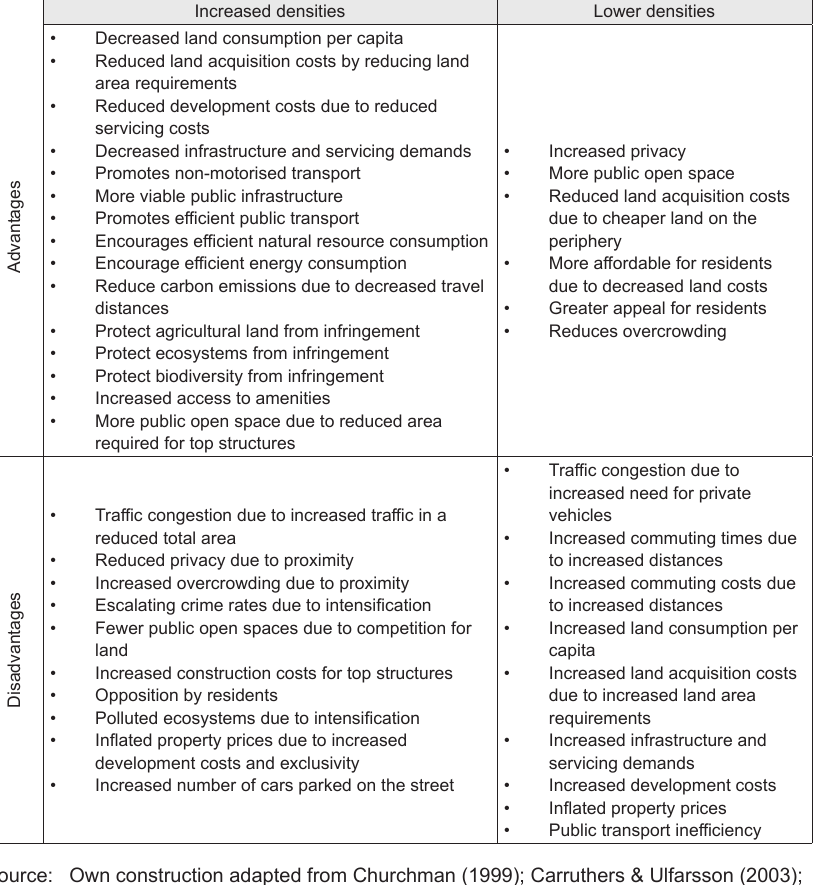
Advantages and disadvantages of both lower and increased densities Increased densities Lower